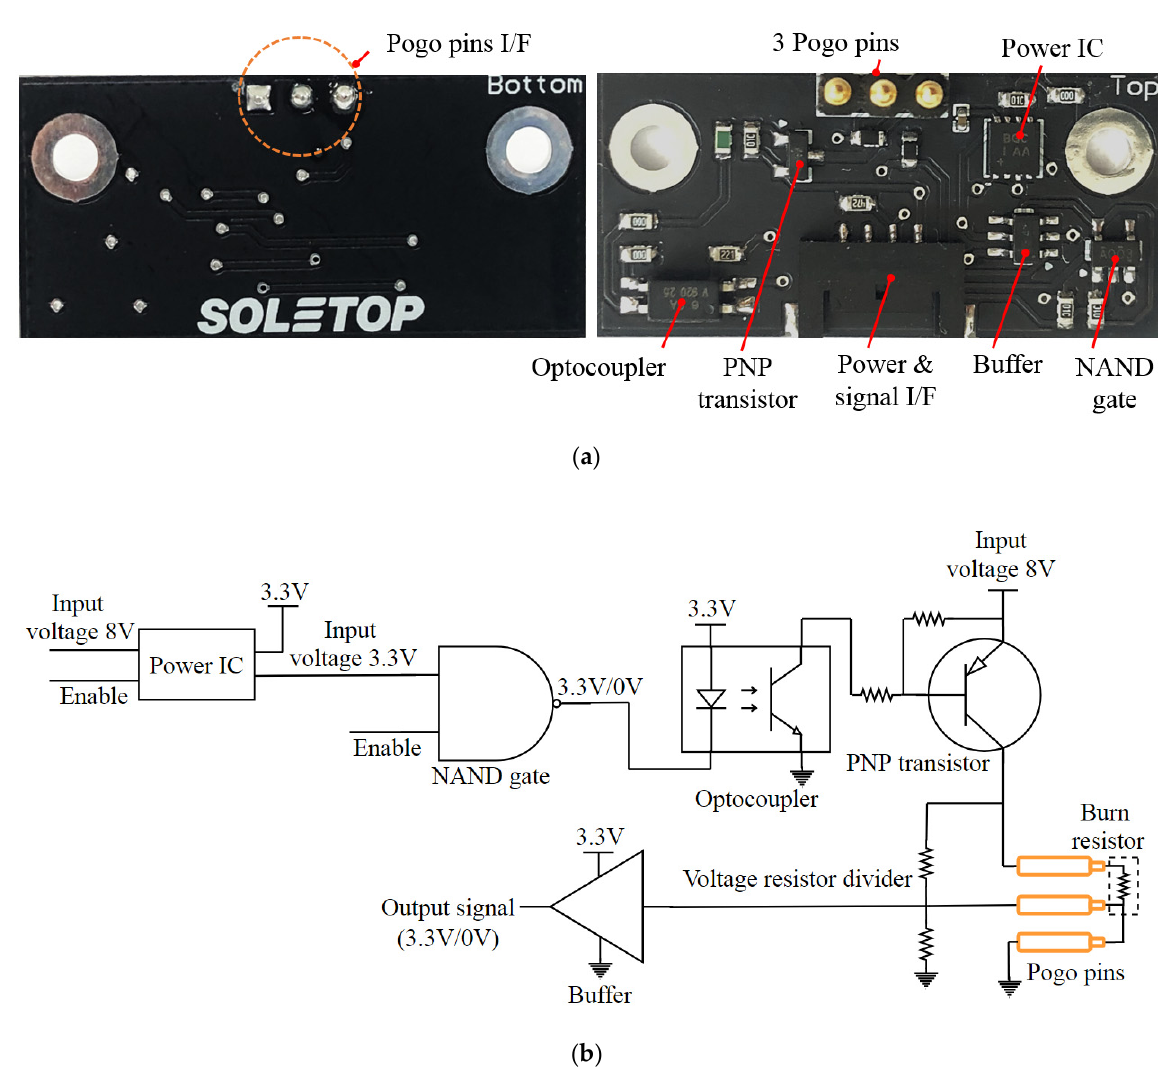
Figure 6. Three-pogo pin-based mechanism’s electrical system: ( a ) front and rear view of electrical interface PCB (dimensions: 34 mm × 16 mm × 1 mm) ( b ) schematic block diagram.